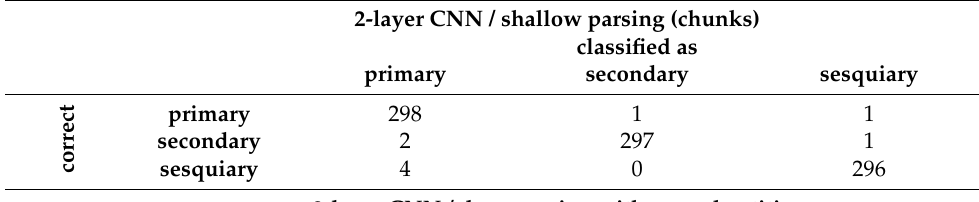
Table 9. Contingency tables for the top three highest scoring classifiers.